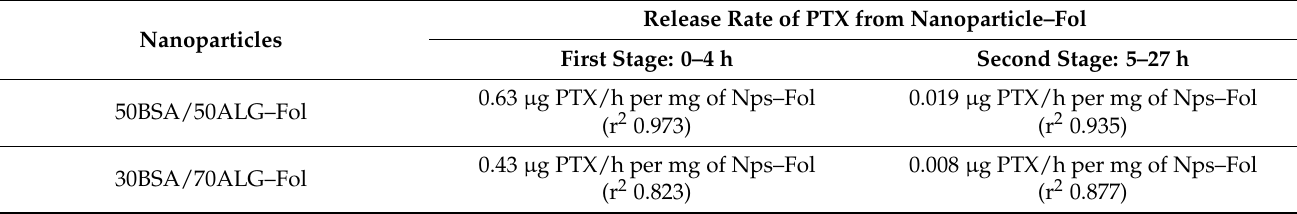
Table 4. Release rates of PTX from 50BSA/50ALG–Fol and 30BSA/70ALG–Fol